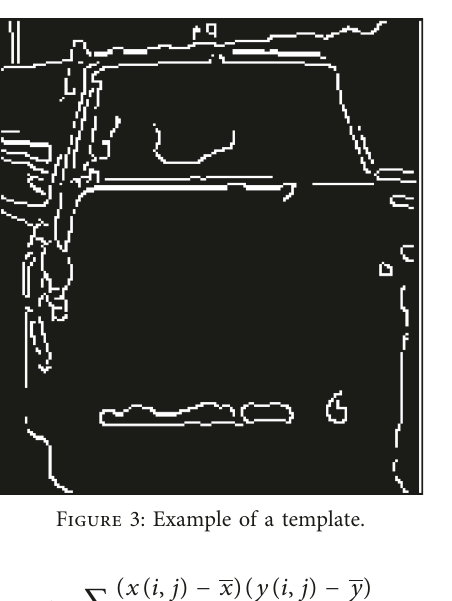
Figure 3: Example of a